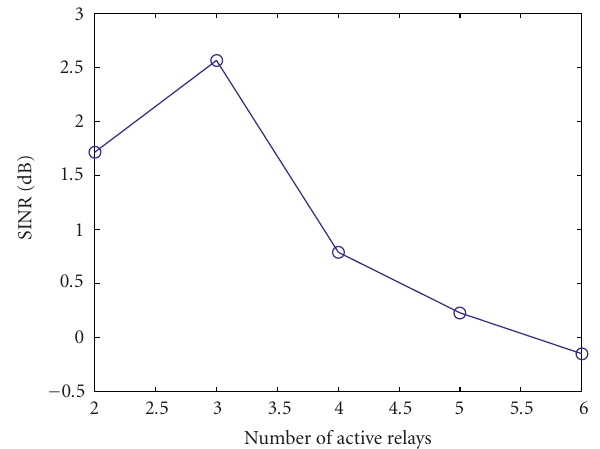
Figure 10: The received SINR at 5 percentile with the di ff erent number of active relays on an urban environment with a cell radius of 500 m.